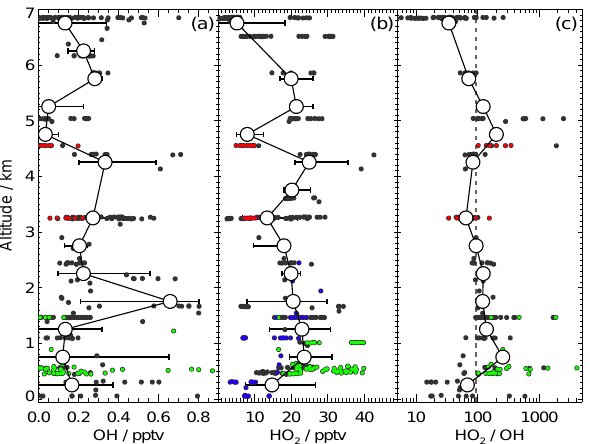
Fig. 12. Median altitude profile of (a) OH (pptv, black), (b) HO 2 (pptv, black) and (c) HO 2 /OH ratio for data between 09:00 and 15:00UTC. Median values in 500m altitude bins are shown as large joined circles, with error bars indicating one standard devi- ation from the mean. The median HO 2 /OH ratio of 95 is shown as a grey dashed line. 60s data are shown as small black dots, with specific data discussed in the text highlighted: Green points indi- cate high isoprene, red points are data identified as biomass burn- ing, blue points indicate cloud sampling, white points highlight data high altitude data collected on flight B228.